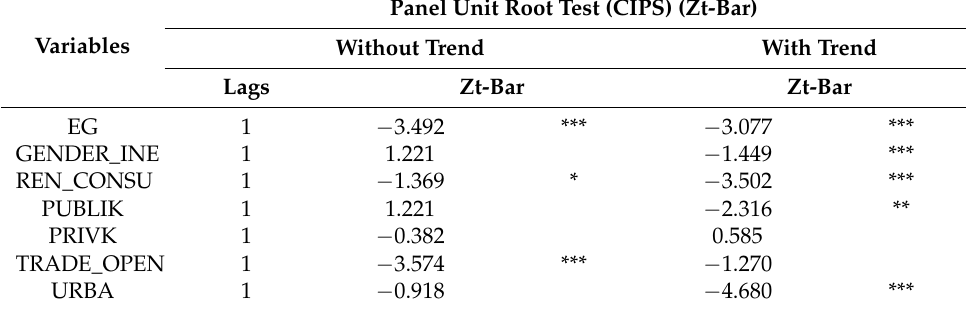
Table 7. Panel unit root test (CIPS test).